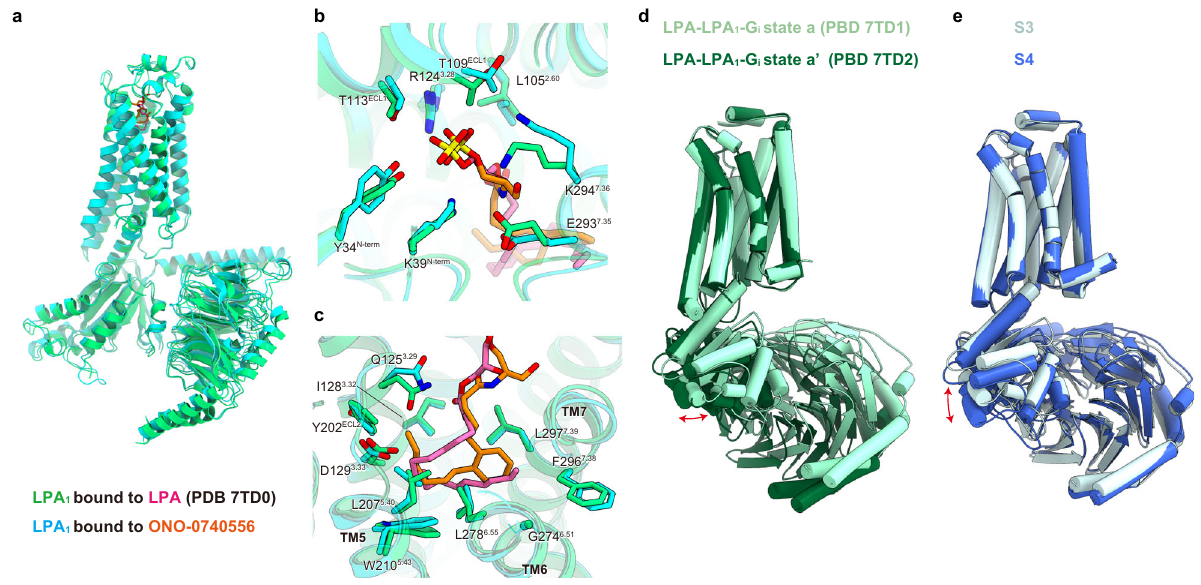
Fig. 7 | Structural comparison of LPA 1 bound to LPA and ONO-0740556. a Superimposition of the LPA- and ONO-0740556-bound LPA 1 structures, colored green (PDB 7TD0) and cyan, respectively. b , c Superimposition of the binding pocketforLPAandONO-0740556inpolarregionsontheextracellularside( b ),and